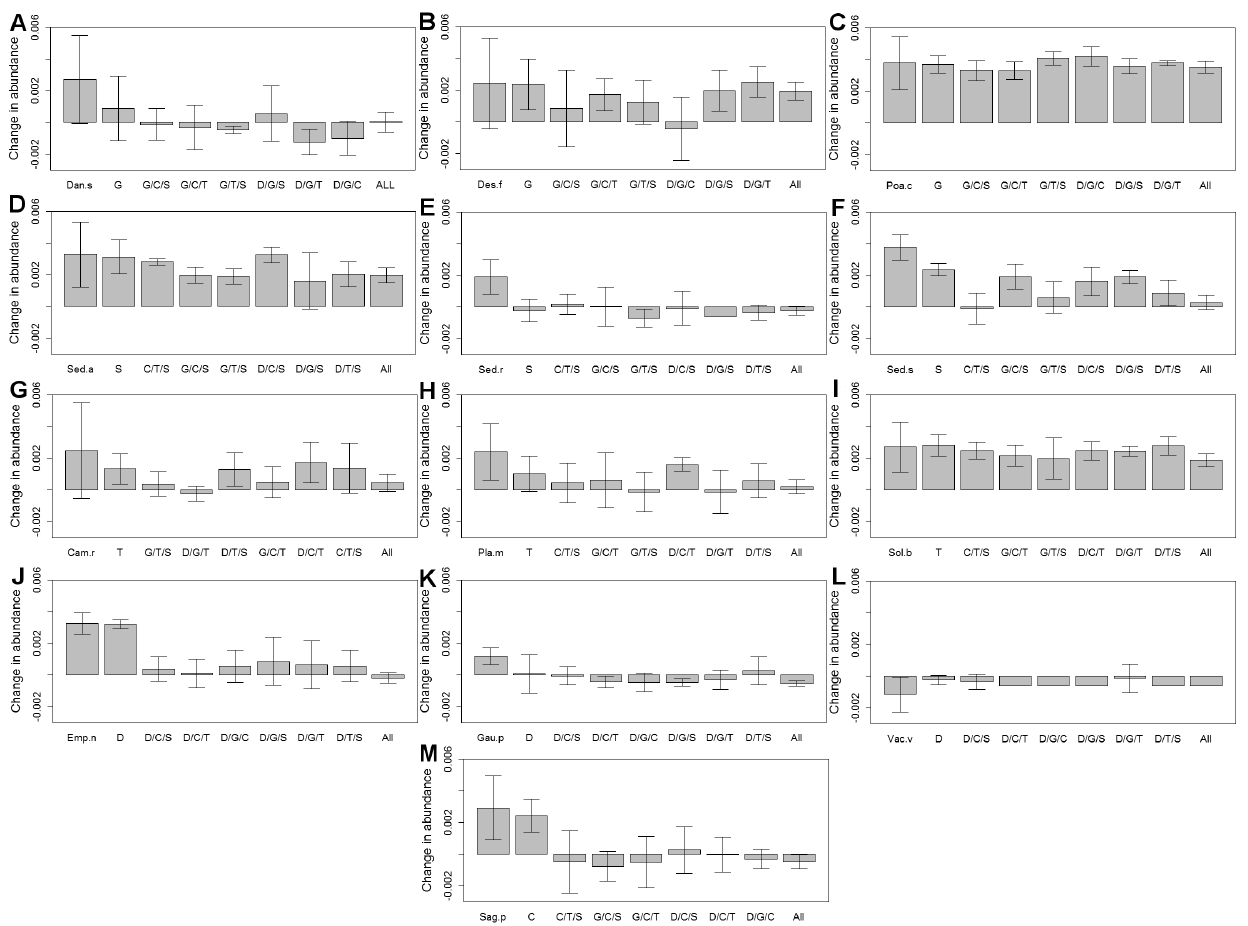
Figure 3. Change in abundance of 13 species in monoculture and mixtures over four years (mean ± 95% CI). Change in abundance calculated using canopy density: (ln(canopy density in year 4) - ln(canopy density in year 1))/ # days. A: D. spicata ; B: S. acre ; C: C. rotundifolia ; D: